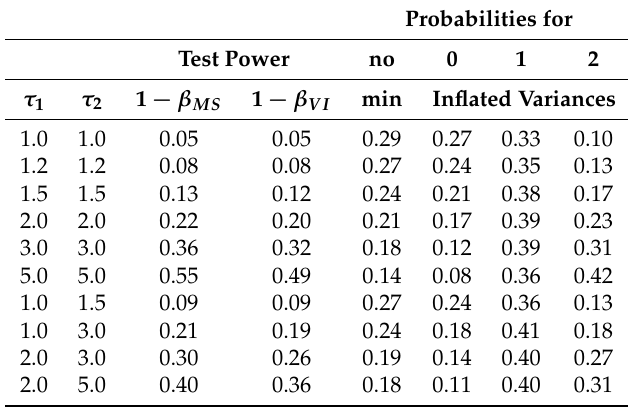
Table 3. Test power 1 − β MS for test using T MS in (31) and test power 1 − β VI for test using T VI in (59) for various true values of the variance inflation factors τ 1 , τ 2 for σ W = 0.1 · σ 1 = 0.1 · σ 2 and α = 0.05, as well as probabilities that (16) has no local minimum or that 0 or one or two variances are inflated. Probabilities